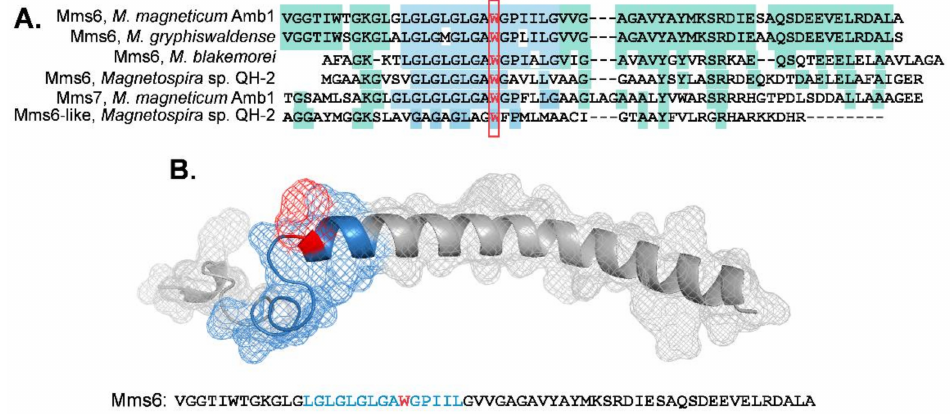
Figure 4. Primary and tertiary structural analysis of Mms6: ( A ) alignment of Mms6 and proteins with related sequence. Primary sequences were obtained from the NIH protein database (http: //www.ncbi.nlm.nih.gov/protein, accessed on 12 June 2021) and aligned using the clustalw2 online server. The colored regions indicate identity of sequence with the blue region identifying the GL domain and the red rectangle the conserved tryptophan; ( B ) the AlphaFold2 predicted structure for Mms6 with the conserved Trp and GL domain identified and the primary sequence below. See Figure S8 for 3D models of Mms6 predicted by other